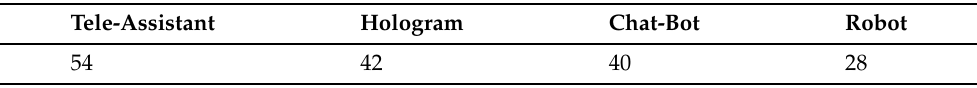
Table 3. Borda Count Results: Preferences for Digital